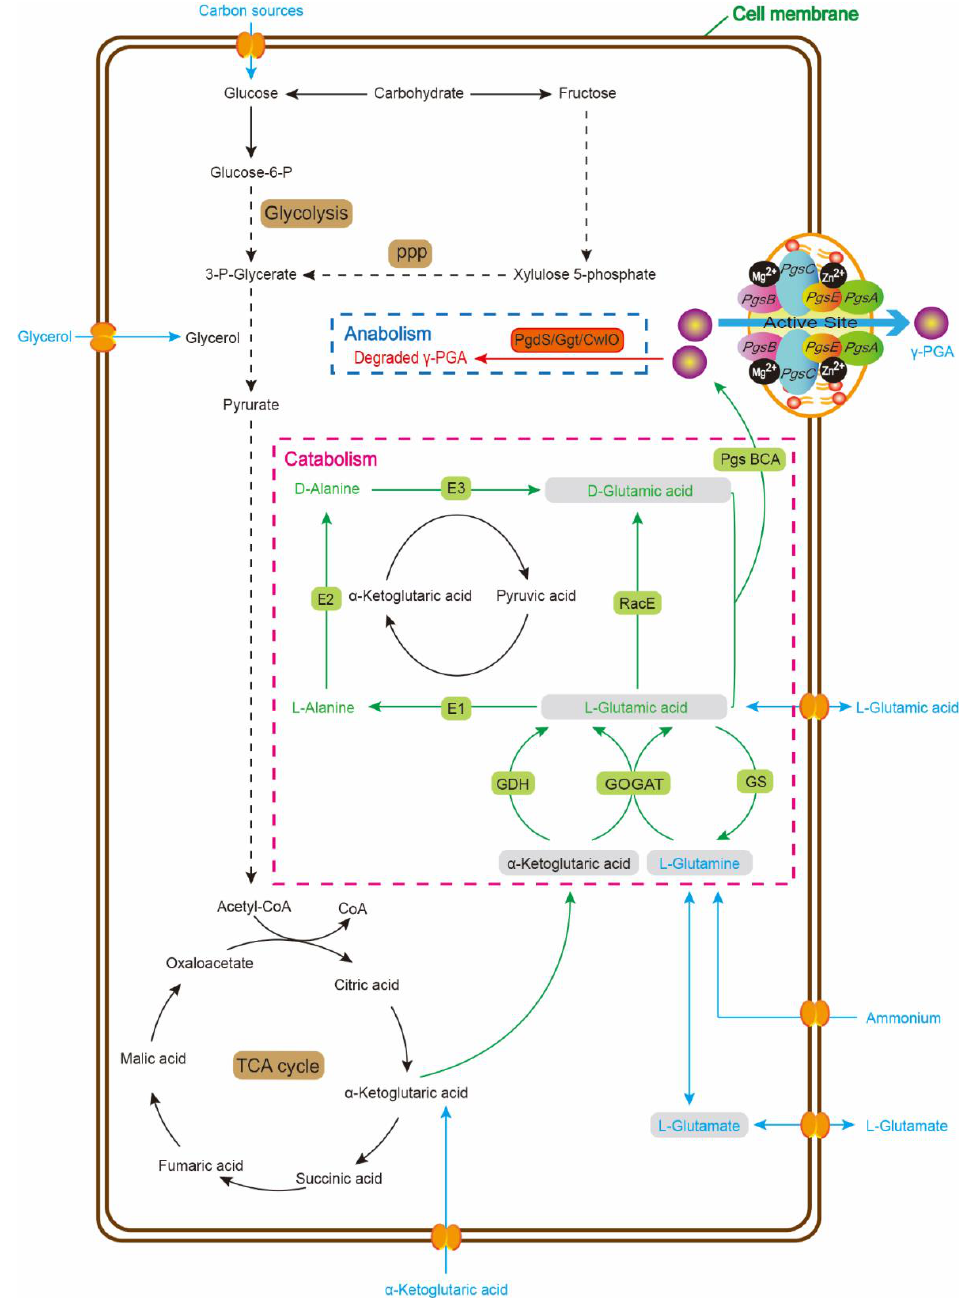
Figure 2. The synthetic pathway of γ-PGA. Main biologically synthetic pathway of γ-PGA involves three steps: racemization, polymerization and transfer, and catabolism. Various substrates (e.g., glucose, citric acid, glycerol, biomass materials, and by-products) enter by the main anabolism pathway. For glutamate-independent strains, they can utilize exogenous nutrients to product γ-PGA through glycolysis, PPP, and TCA cycle. Instead, for glutamate-dependent strains, glutamic acid or glutamate are added to the medium directly to product γ-PGA. PPP, Pentose Phosphate Pathway; G3P, glyceraldehyde 3-phosphate; TCA cycle, Tricarboxylic Acid cycle; E1, pyruvic acid aminotransferase (L-Glutamic acid); E2, alanine racemase; E3, pyruvic aminotransferase (D-Glutamic acid); RacE, glutamate racemase; Pgs, γ-PGA synthetase (four gene subunits operons: pgsB , C , A and E ); GDH, glutamate dehydrogenase; GS, glutamine synthetase; GOGAT, glutamate synthase or glutamine oxoglutarate aminotransferase. PgdS, γ-PGA hydrolase; Ggt, γ-glutamyl transferase; CwlO, cell wall lyases.